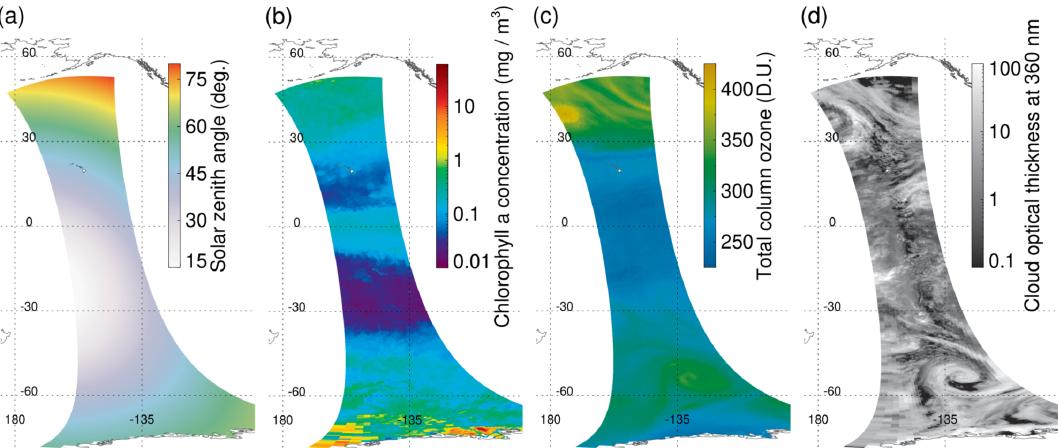
Figure 6. Maps of the main input parameters: ( a ) solar zenith angle; ( b ) chlorophyll concentration in mg/m 3 ; ( c ) ozone amounts in DU; and ( d ) effective cloud optical depth at